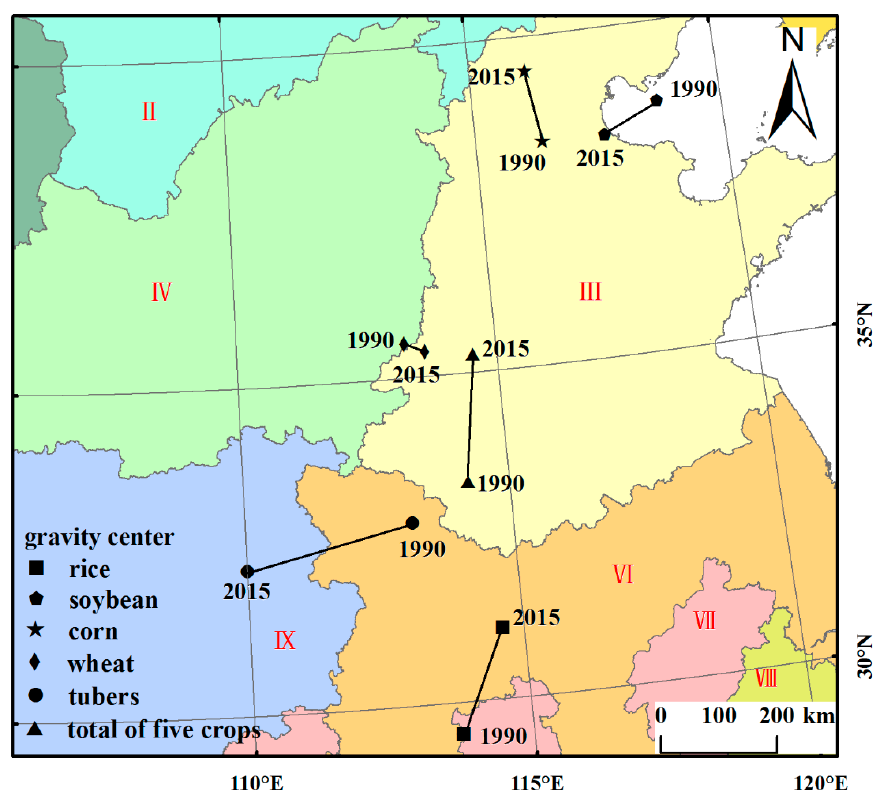
Figure 4. Geographic imbalances between farmland and water resources in 2015.